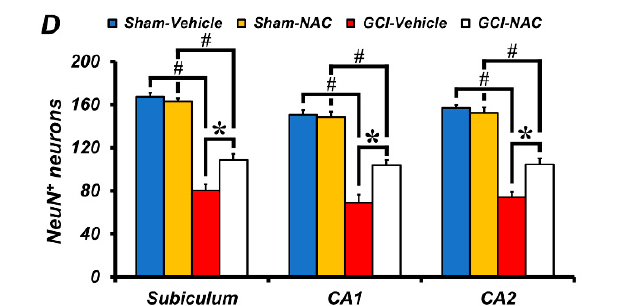
Figure 6. Post administration of NAC reduces GCI-induced behavioral outcome deficits and delays neuronal loss. ( A ) The adhesive removal test to assess sensorimotor deficit was conducted at both 3 h and 7 days after sham and GCI surgery. Sham groups showed no di ff erence in time to remove the adhesive tape during the test. GCI–vehicle group took significantly longer to remove the tape. Post treatment of NAC after GCI reduces removal time (time dependently). Data are mean ± SEM, n = 5–8 each group, * p < 0.05 versus vehicle-treated group; # p < 0.05 versus sham-operated group (repeated measure test followed by ANOVA, time: F = 6.365, p < 0.001; group: F = 33.354, p < 0.001; time * group: F = 3.061, p < 0.001). ( B ) The mNSS was conducted at 3 h and 7 consecutive days after sham and GCI surgery. Sham groups indicate a 0 score which means all tasks were performed completely without defect. Under the ischemic condition, the vehicle group showed a failure of mNSS sessions. Post administration, NAC improved mNSS procedures and reduced failure of tasks. Data are mean ± SEM, n = 6–8 each group, * p < 0.05 versus the vehicle-treated group (repeated measure test followed by ANOVA, time: F = 35.621, p < 0.001; group: F = 17.576, p = 0.001; time * group: F = 2.322, p = 0.032). ( C ) Immunohistochemistry images show NeuN-positive neurons in the hippocampal subiculum, CA1, and CA2 regions. Scale bar = 50 µ m. ( D ) Bar graph shows analysis of NeuN-positive cells in each hippocampal region. Post treatment of NAC restores GCI-induced delayed neuronal loss in the following 7 days. Data are mean ± SEM, n = 5–6 each group, * p < 0.05 versus vehicle-treated group; # p < 0.05 versus sham-operated group (Kruskal–Wallis test followed by Bonferroni post-hoc test, Subiculum: chi square = 17.792, df = 3, p < 0.001; CA1: chi square = 17.958, df = 3, p < 0.001; CA2: chi square = 17.735, df = 3, p < 0.001).